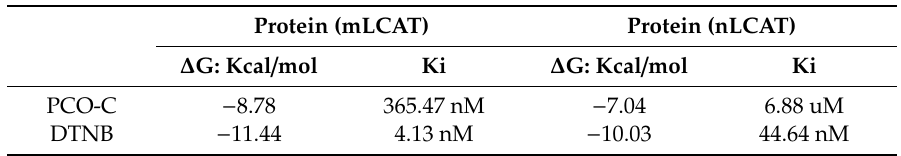
Table 8. Interaction energy of PCO-C and dithiobis-nitrobenzoic acid (DTNB) with Lecithin